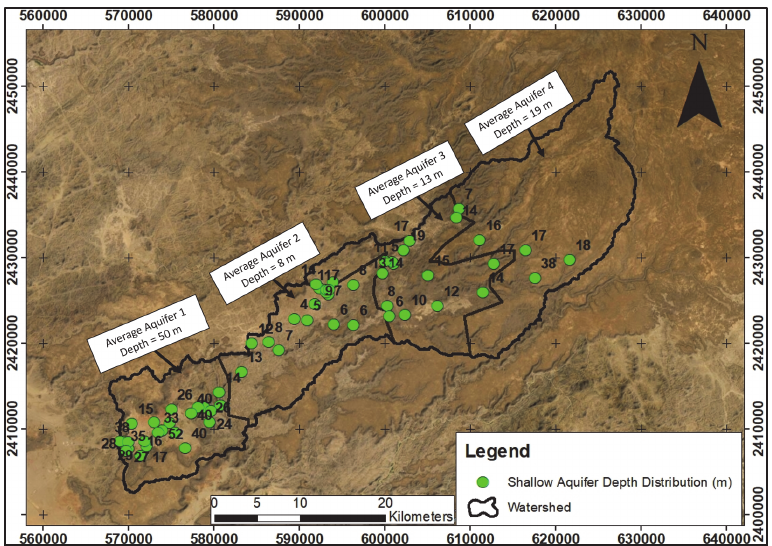
Figure 13. Shallow aquifer depth distribution overlayed with satellite image.